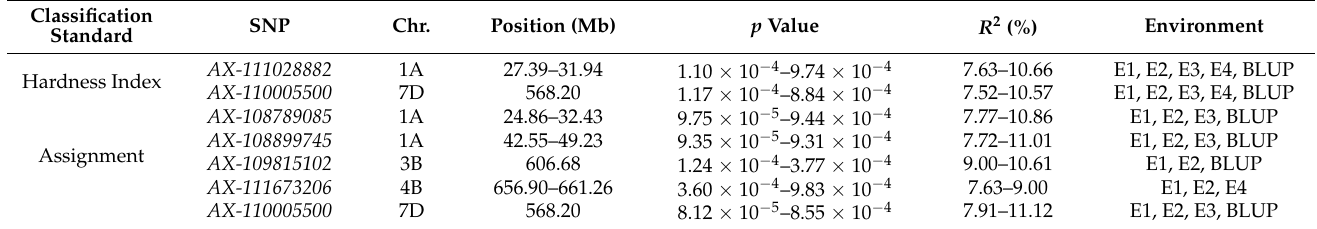
Figure 3. Manhattan plots for best linear unbiased predictions (BLUP) of HI of 150 wheat varieties (lines) by the mixed linear model (MLM). ( A ) Manhattan chart of hardness index; ( B ) Manhattan chart of assignment method. Table 3. Stable locus information with a significant correlation of HI.